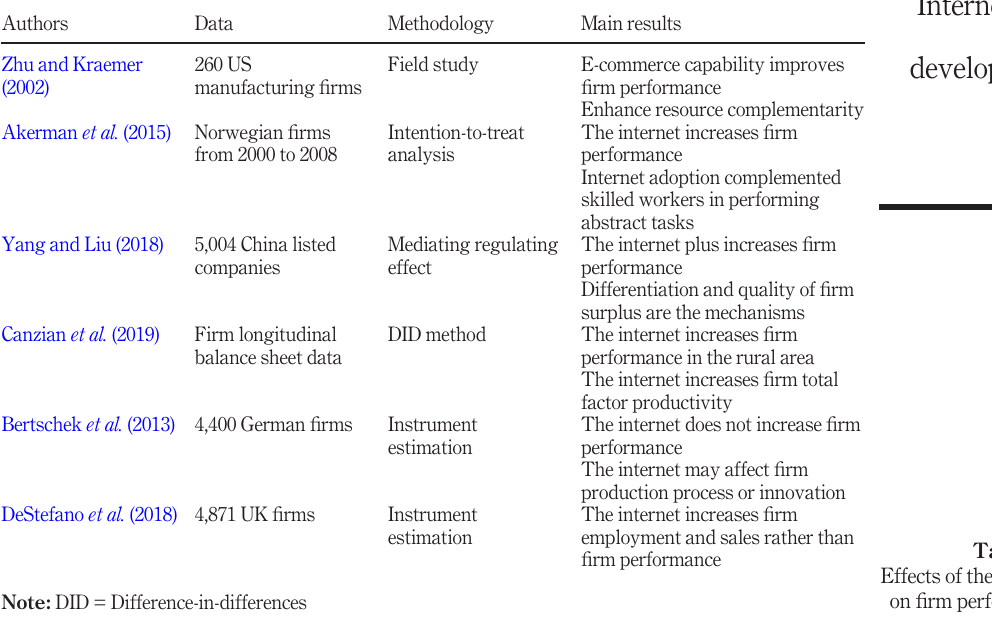
Table IV. Effects of the